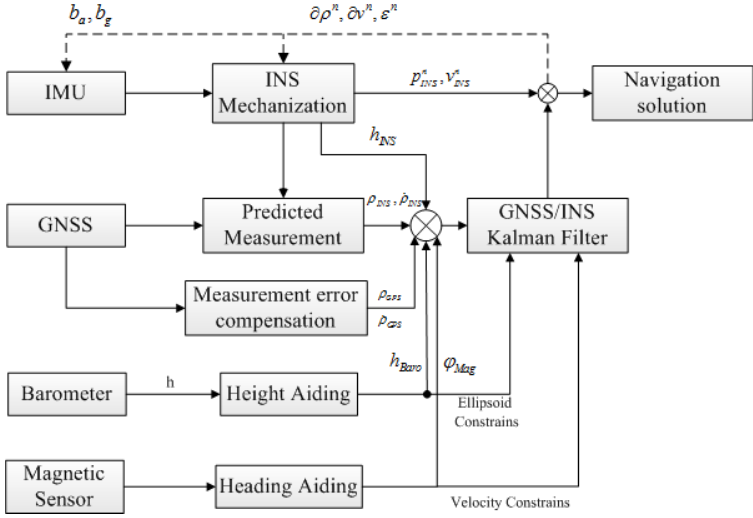
Figure 3. External measurement aiding system